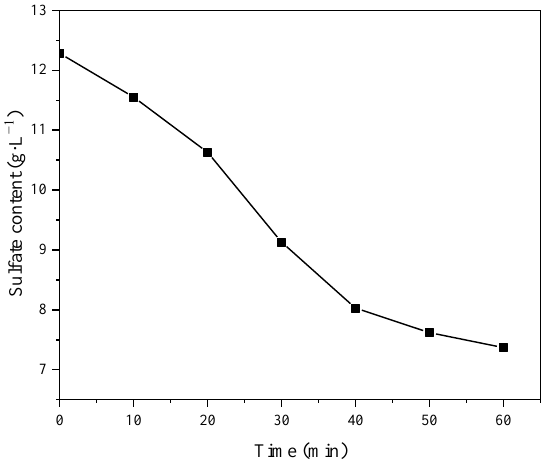
Figure 20. Change curve of SO 42 − content in two-stage ED with time.